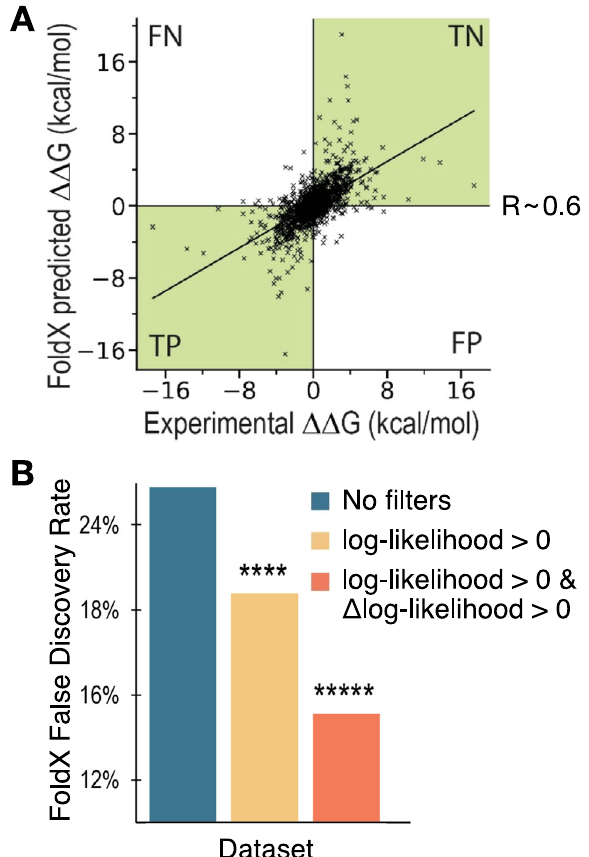
Fig. 1 | Phylogenetic informationreducesfalsediscoveryrate.A Comparison of the experimental ΔΔ G against the FoldX-predicted ΔΔ G values. Labels are applied to the four quadrants of the graph. (FN: False Negatives, TN: True Negatives, TP: True Positives, FP: False Positives). The Pearson correlation coef fi cient (R) for the datasetisalsoshown. Thegreenquadrantsidentify mutationswhose overalleffect (stabilizing or destabilizing) is correctly predicted. B Bar plot of the FDR of the FoldX prediction obtained by applying different fi ltering based on phylogenetic information(seelegend).ThePSSMsemployed wereobtained withHHblits 57 using a coverage parameter of 60 and identity of 95. Statistical signi fi cance was calcu- lated explicitly with random resampling (see Supplementary Methods, **** p <0.0001 and ***** p